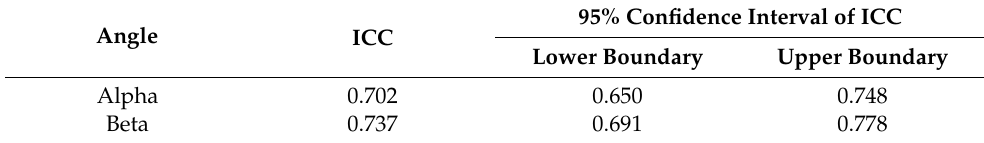
Table 3. Inter-rater reliability of the alpha angle and the beta angle for developmental displacement of the hip evaluation.